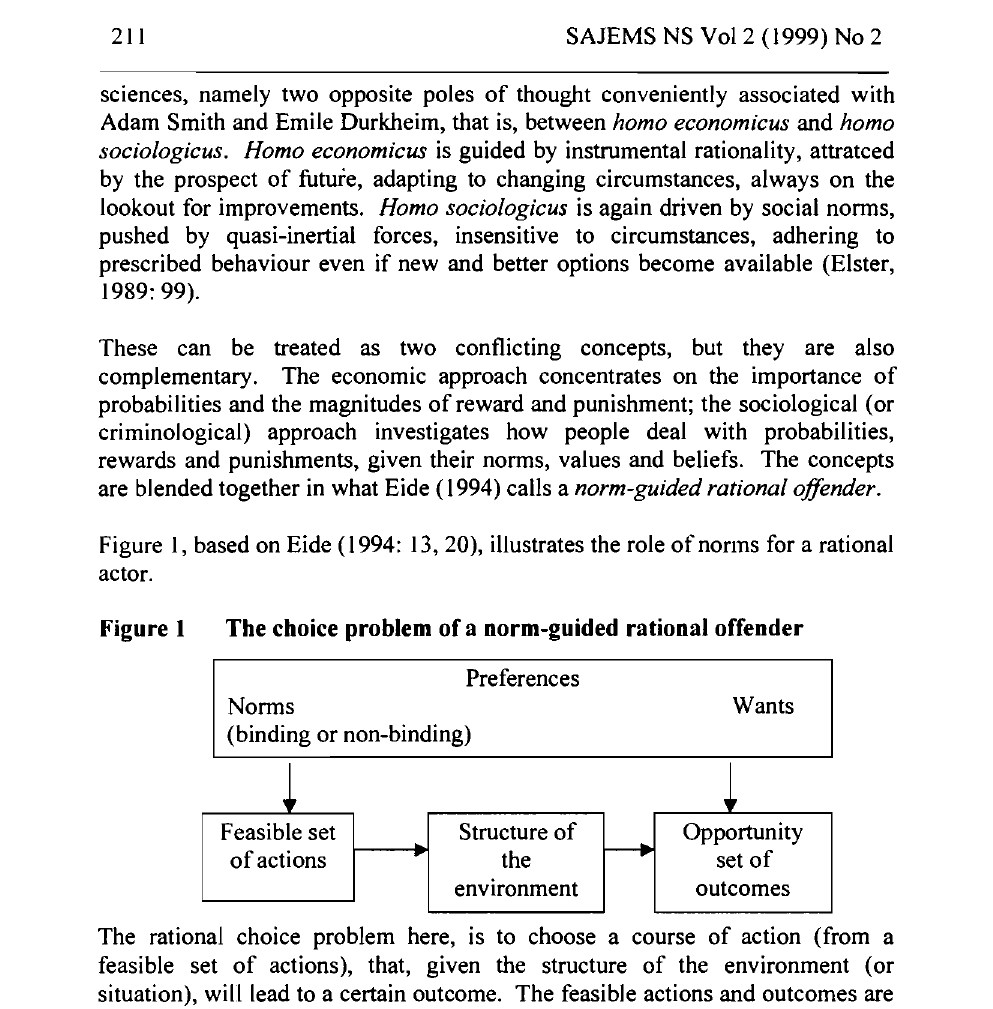
Figure I The choice problem of a norm-guided rational offender Preferences Norms Wants (binding or non-binding) 1 1 Feasible set Structure of ---. Opportunity of actions the set of environment